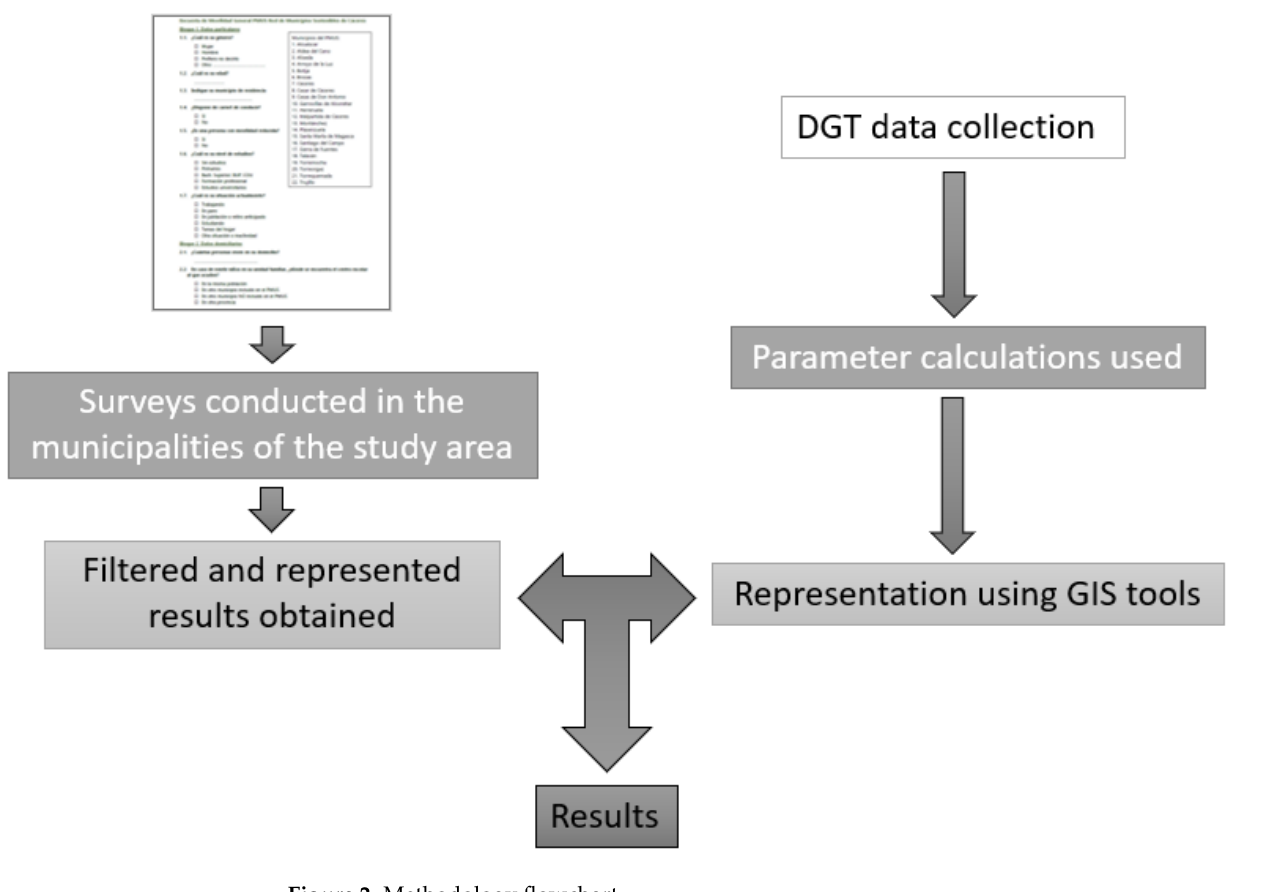
Figure 2. Methodology flowchart.